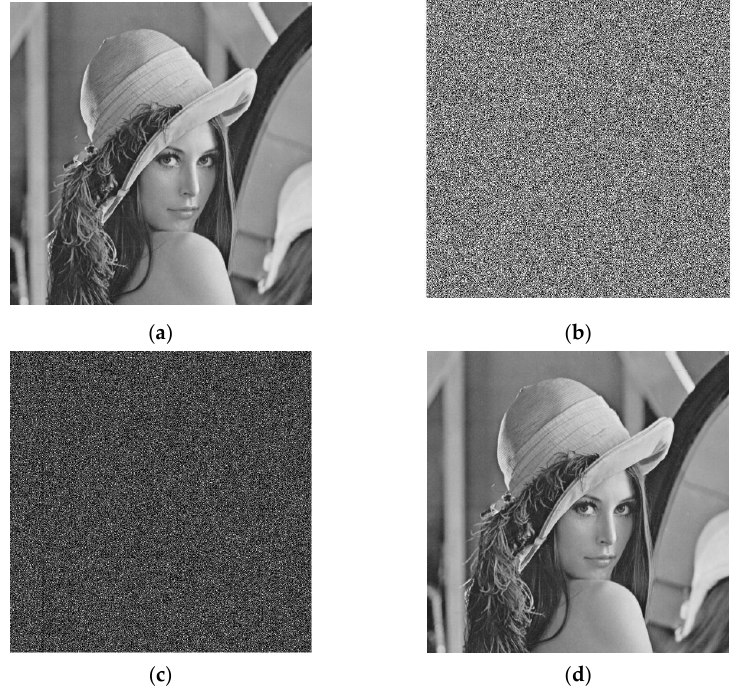
Figure 4. Key sensitivity: ( a ) original “Lena,” ( b ) encrypted “Lena” with the original initial conditions, ( c ) decrypted “Lena” with the modified key, and ( d ) decrypted “Lena” with the original key.